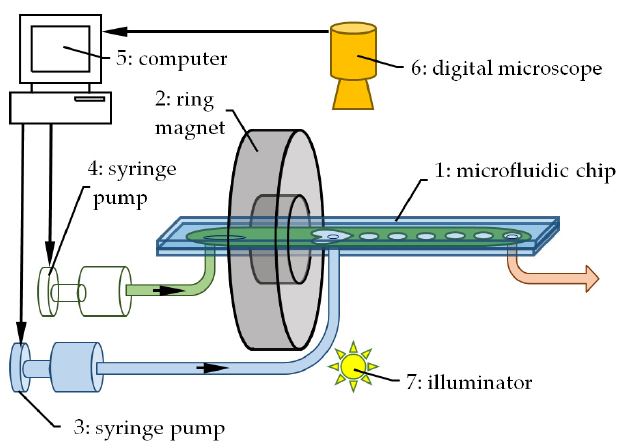
Figure 1. Experimental setup block diagram.